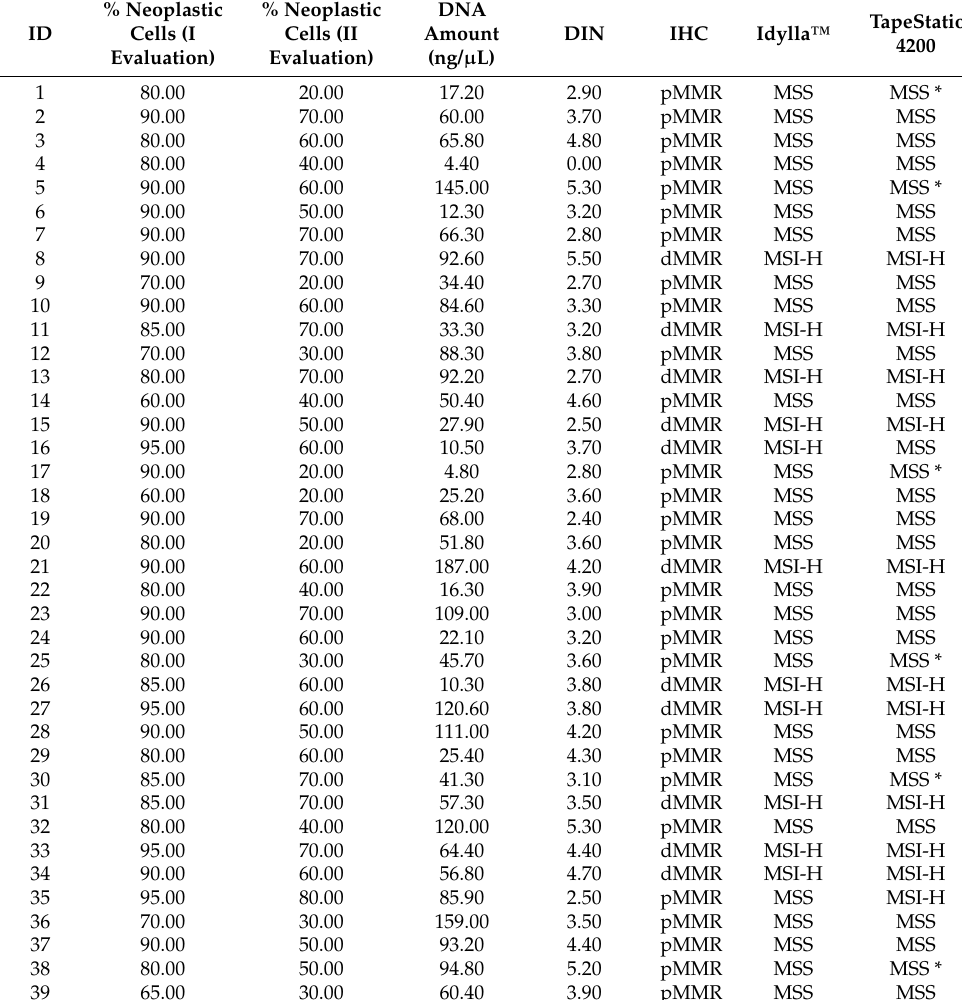
Table 5. Summary of molecular analysis of MMR/MSS status for gastric cancer